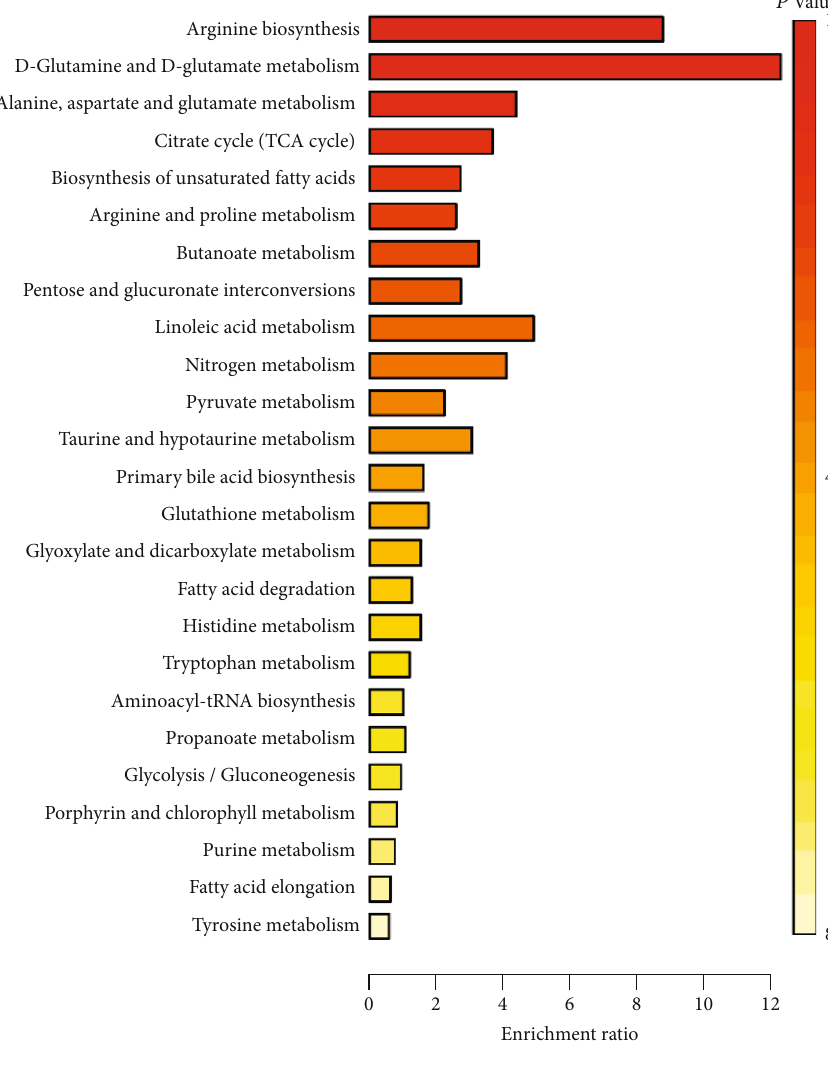
Figure 3: KEGG pathway analysis of